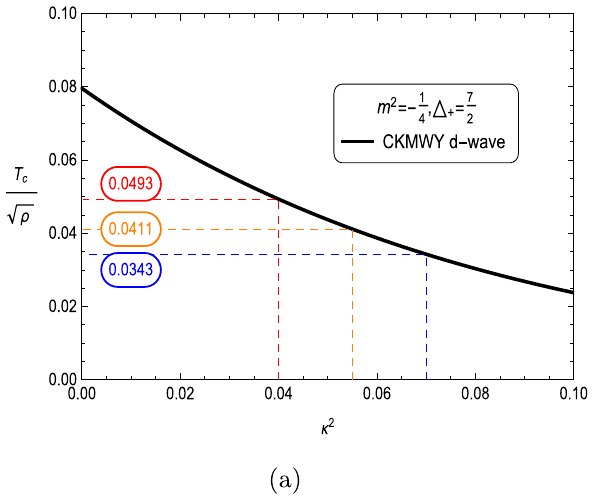
ues, the critical temperatures are T c / √ ρ = 0 . 0411 (orange: κ 2 = 0 . 055) and T T c / κ 2 = 0 . 04)